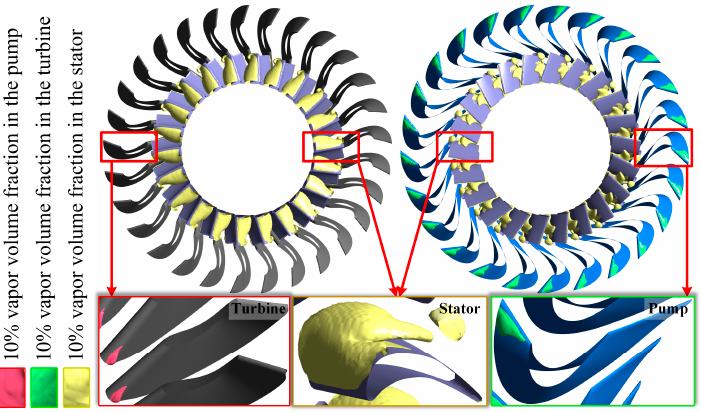
Figure 7. The 10% vapor volume fraction distribution in torque converter at stall when N P = 3000 rpm.